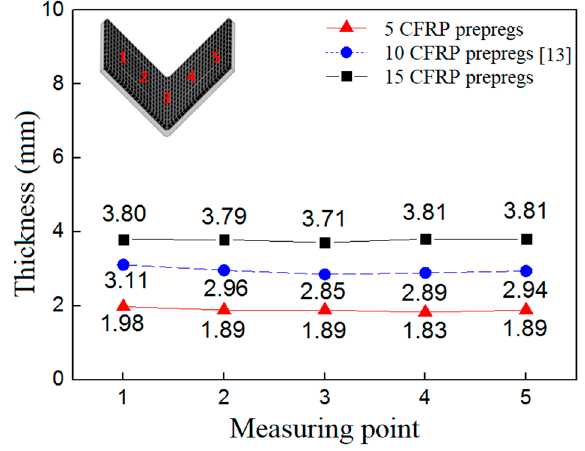
Figure 5. Thickness of CFRP/CR980 hybrid composites at the measuring point.